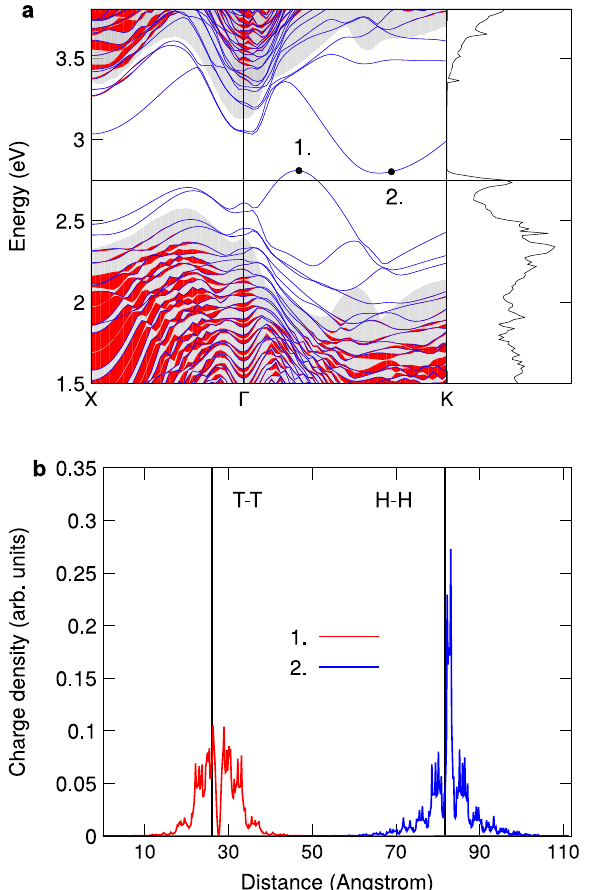
Fig. 3 Localization of electronic states near the Fermi level on domain walls. a Electronic band structure of GeTe containing 39° (11 1 ) tail-to-tail (T-T) and head-to-head (H-H) domain walls (DWs) projected on the DW plane. The eigenvalues of the states with the reciprocal lattice vector normal to the DW plane ( k 3 ) set to zero are shown in blue, while the dispersion of these states as k 3 changes is shown in red. The grey area in the graph corresponds to the bulk GeTe band structure projected to the domain wall plane. The horizontal line represents the Fermi level at 0 K. The absence of dispersion for the states near the Fermi level con fi rms their localization due to electric fi elds along domains. The side plot shows the local density of states of the T-T DW. b Charge density associated with the states labelled as 1. and 2. in a , as a function of the coordinate normal to the DWs, which are indicated by black vertical lines. These states are clearly localized on the DWs.